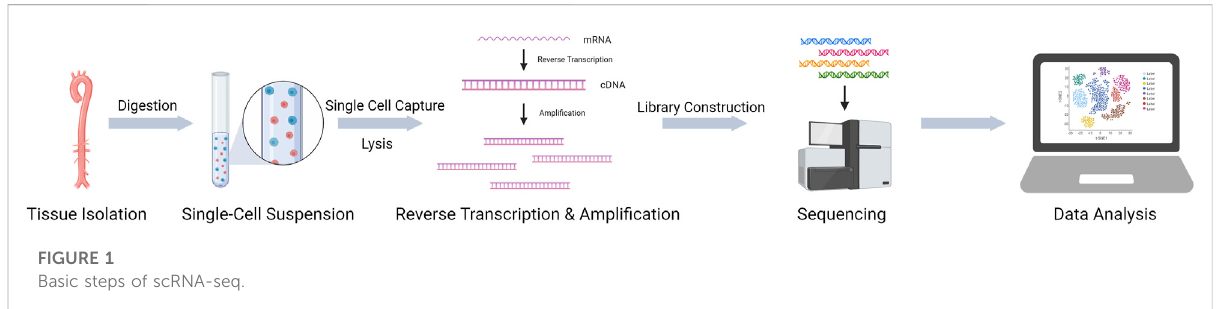
FIGURE 1 Basic steps of